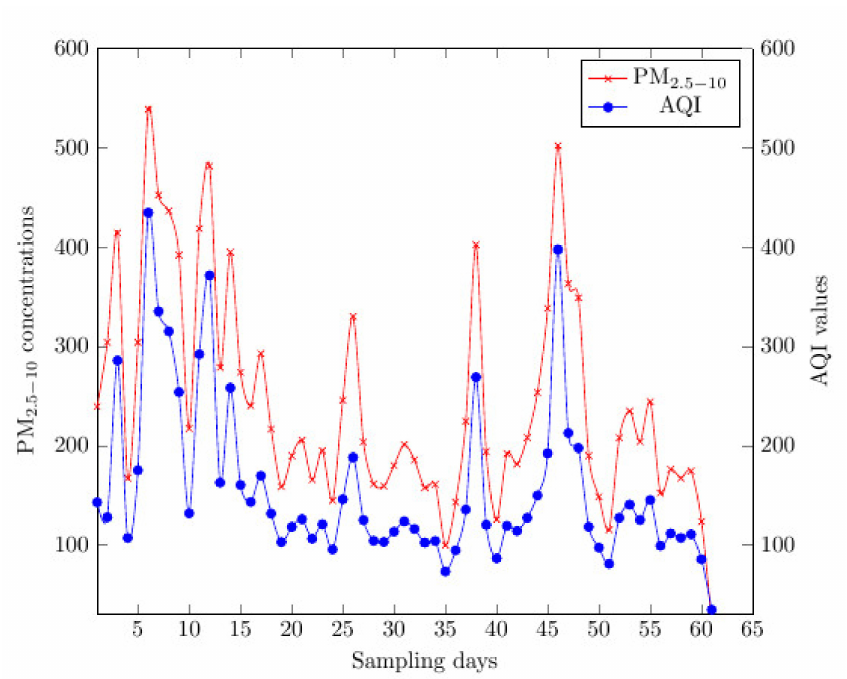
Figure 6. Evolution of PM 2.5–10 concentration and air quality index (AQI) values with